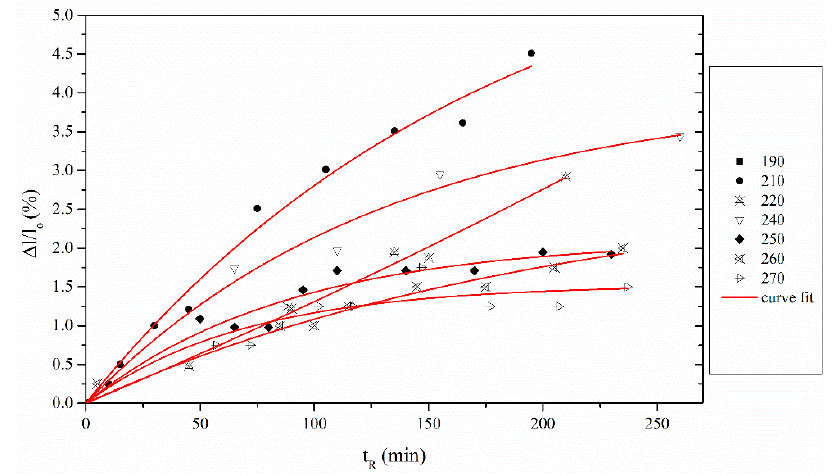
Figure 9. Chemical Shrinkage fitting using stabilization model versus reaction time t R .